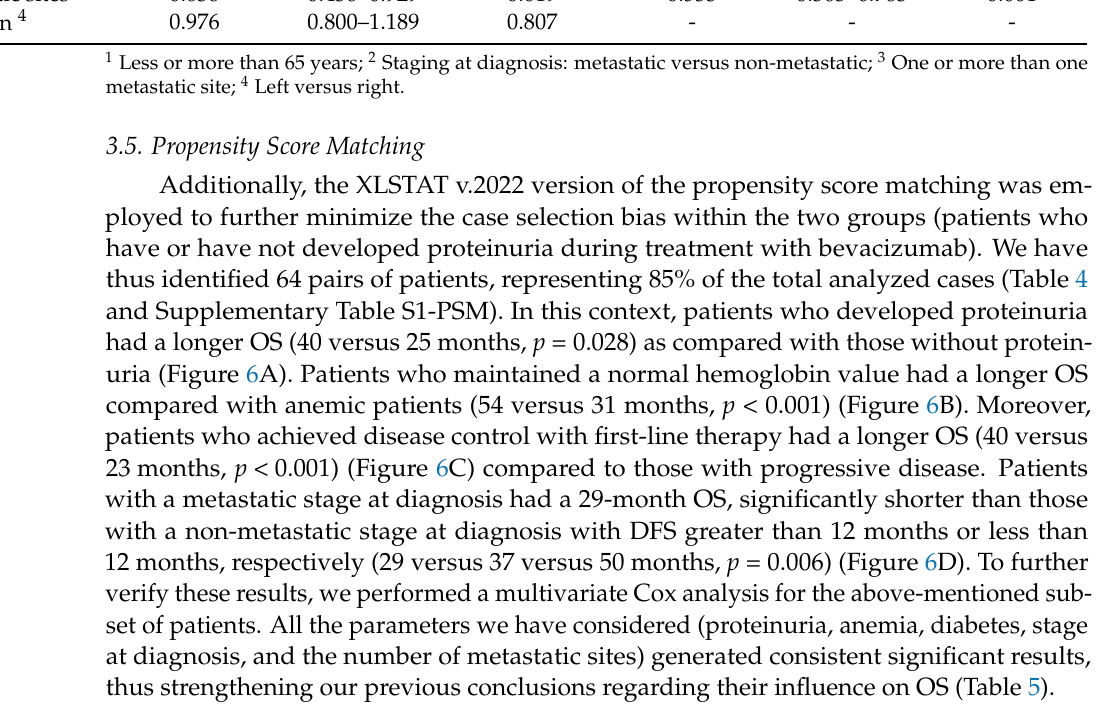
Table 4. Summary of the matched observations according to the presence of